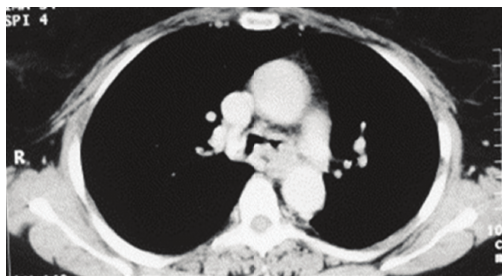
Figure 2: Wall thickening of the main bronchi with bilaterally luminal narrowing.